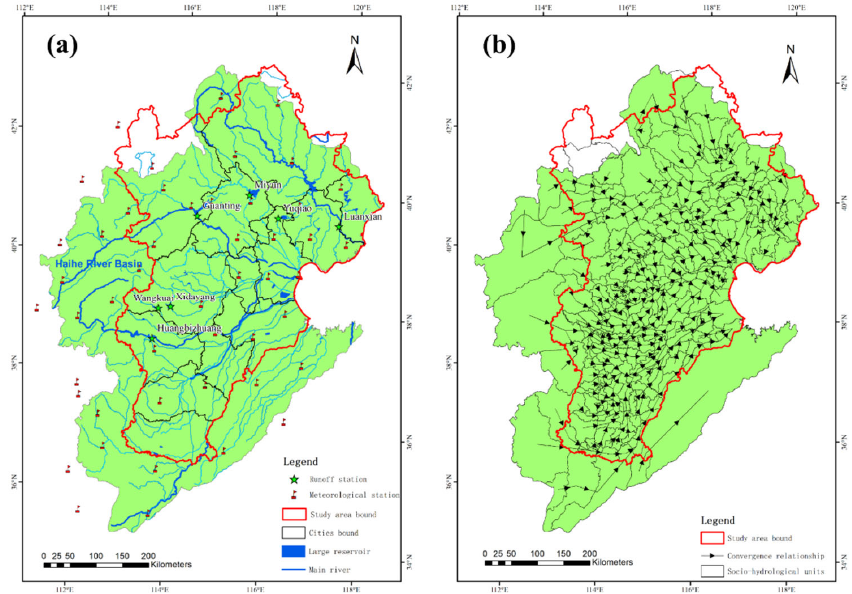
Figure 5. ( a ) Distribution of the meteorological and runoff stations in the study area; ( b ) socio- hydrological units and corresponding convergence relationship in the study area.